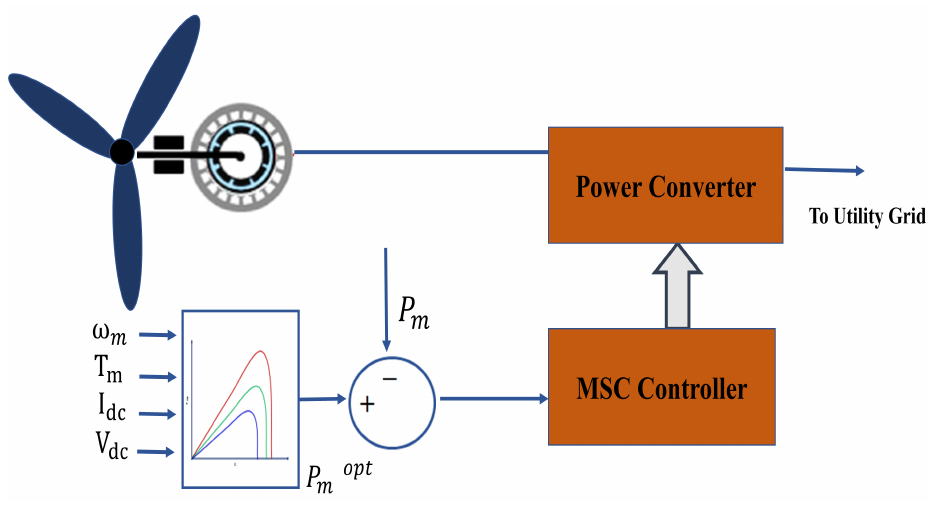
Figure 15. ORB MPPT algorithm. Table 3. Comparison of DPC based MPPT Algorithms for WECS Reused with permission from ref. [32,34,36,68]. Copyright 2012, 2015, 2016